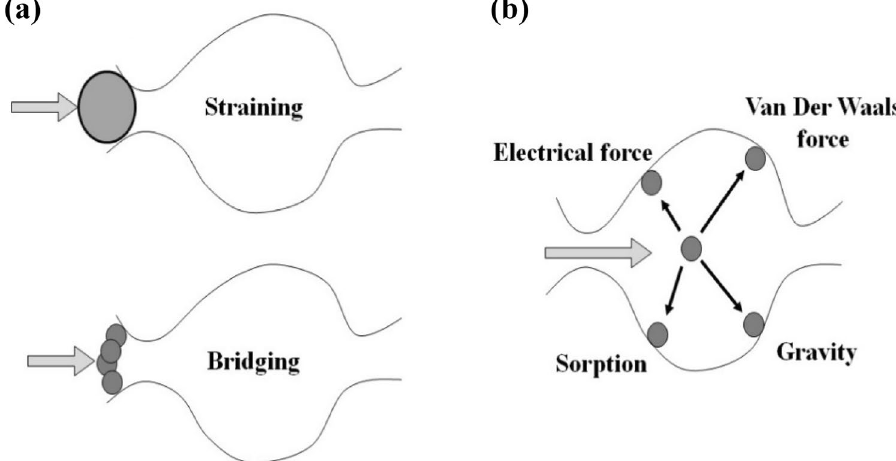
Fig. 1 Main mechanisms of the particle capturing in the porous media (Vaz et al.